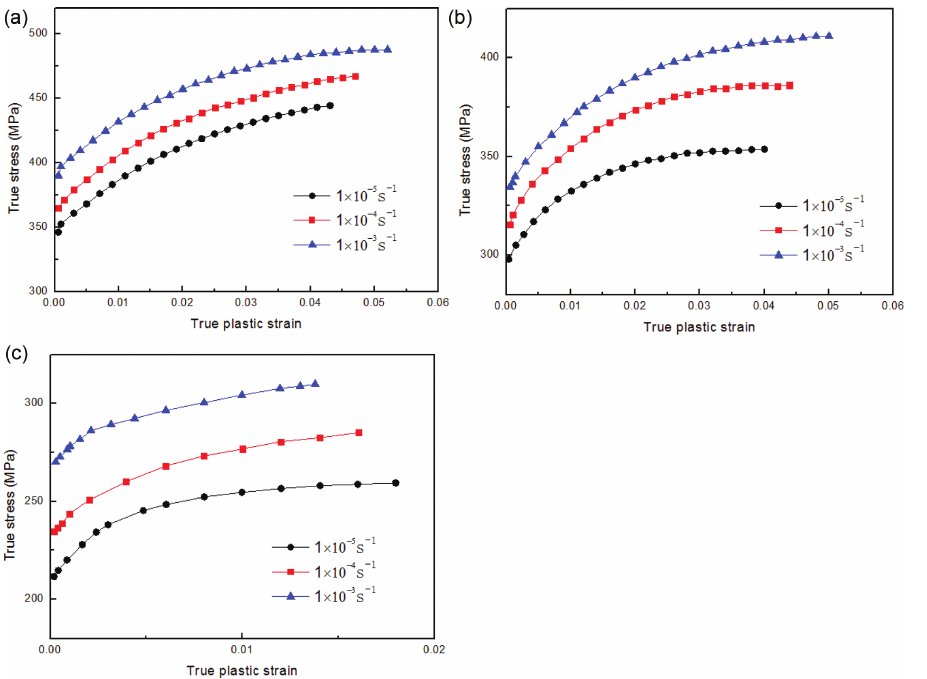
Figure 7: True stress – true plastic strain curves of P92 steel obtained from tensile tests at different strain rate and temperatures of (a) 550°C; (b) 600°C; (c)